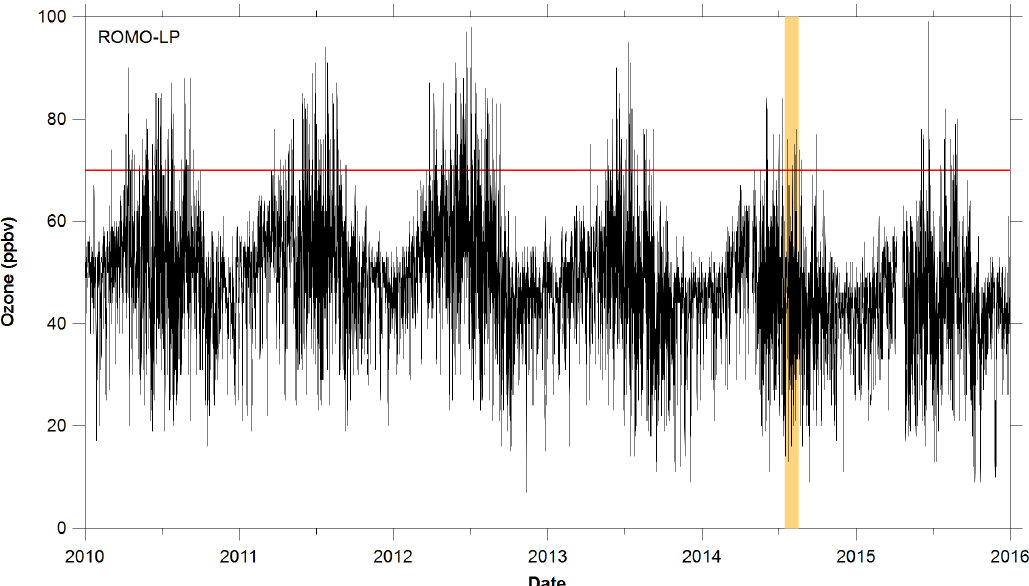
Figure 1. Hourly O 3 measurements at ROMO-LP from January 2010 to December 2015. The red line indicates the current NAAQS 8h daily maximum value of 70ppb. The shaded region designates the FRAPPÉ study